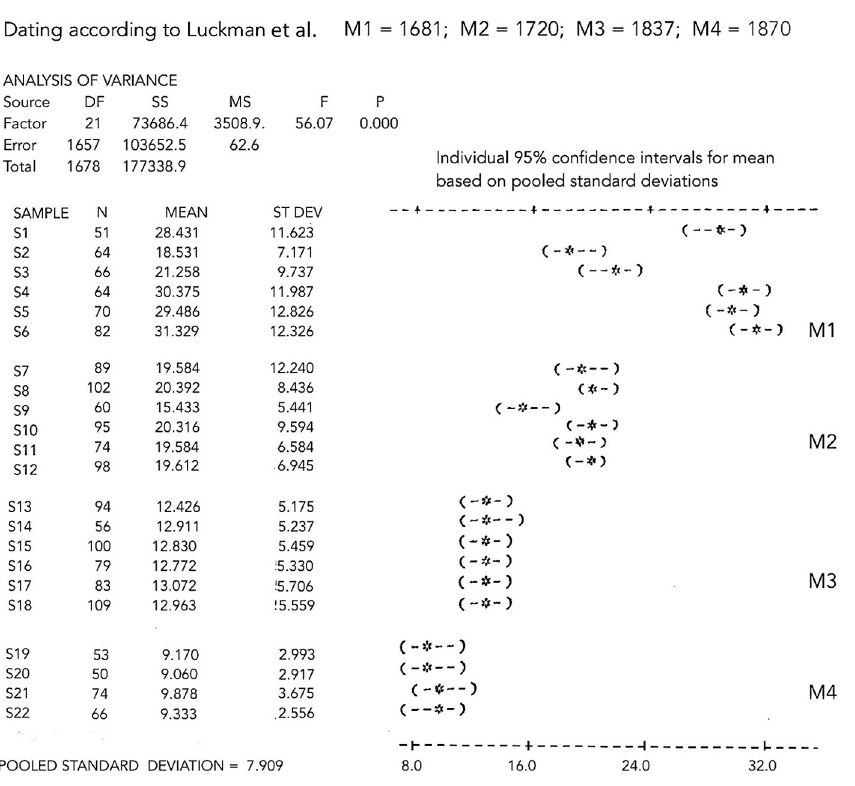
Figure 8. One-way analysis of variance showing age-related differences between sample means (*) on the Cavell moraines, with 95% confidence intervals (in brackets) and misfit samples S2, S3 and S9 included [15].